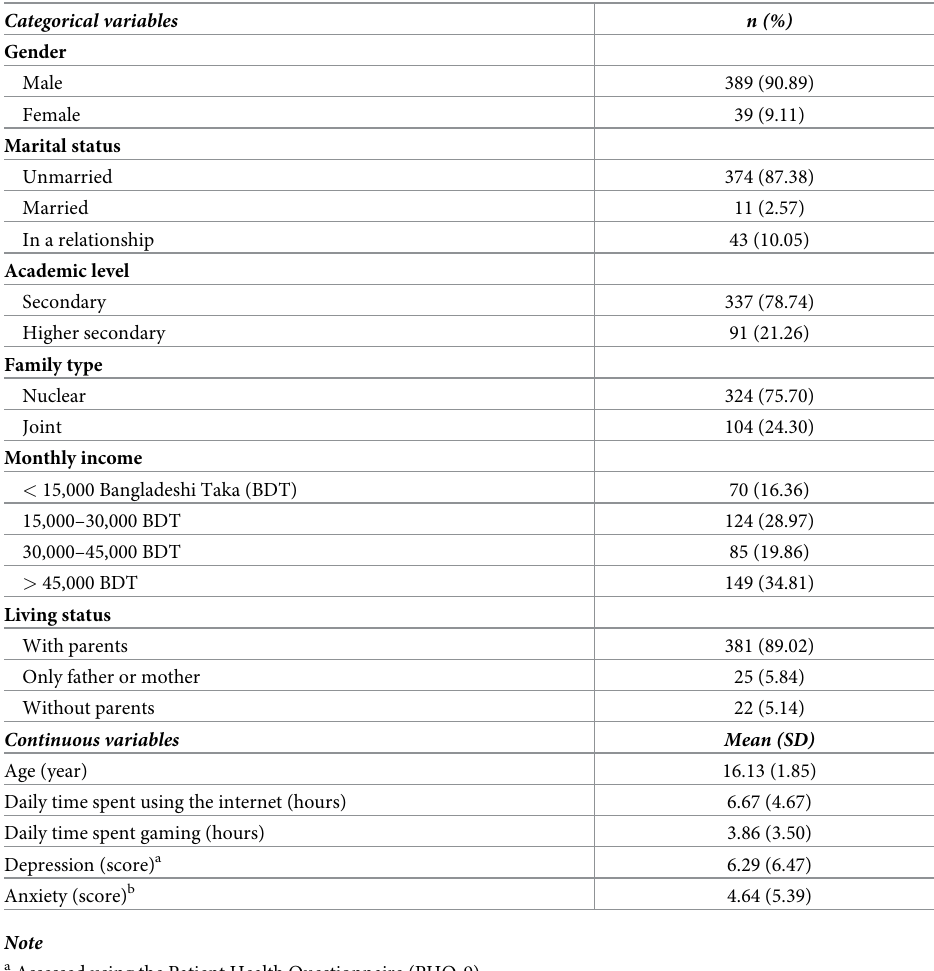
Table 2. Characteristics of the participants ( N = 428).